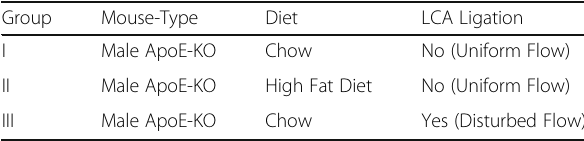
Table 1: (I) ApoE-KO mice/chow diet/no LCA ligation, (II) ApoE-KO mice/HFD/no LCA ligation, and (III) ApoE-KO mice/chow diet/LCA ligation. Mice from